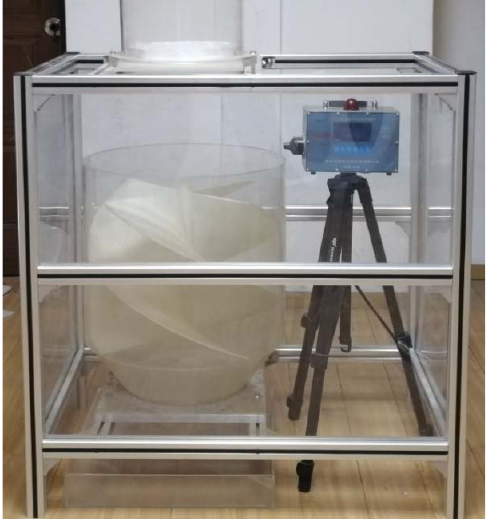
Figure 3. The experimental system of a spiral hopper.